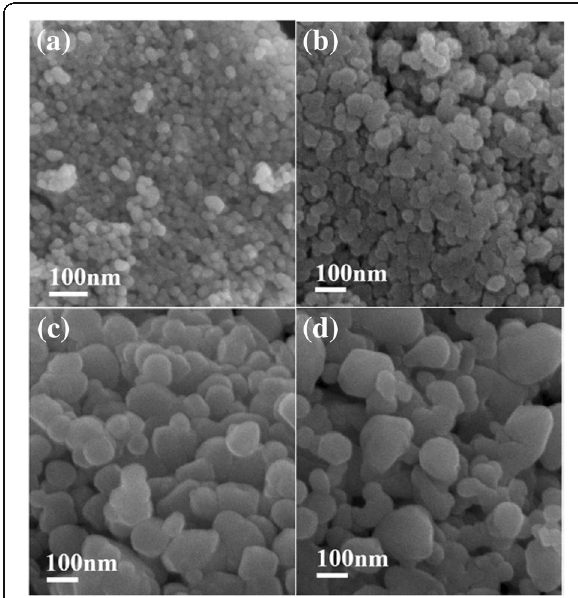
Fig. 7 SEM images of ZnO nanoparticles obtained from 65% ZnCl 2 aqueous solution by reactivity with various hydroxides ( a , NaOH; b , KOH; c , LiOH; d , NH 4